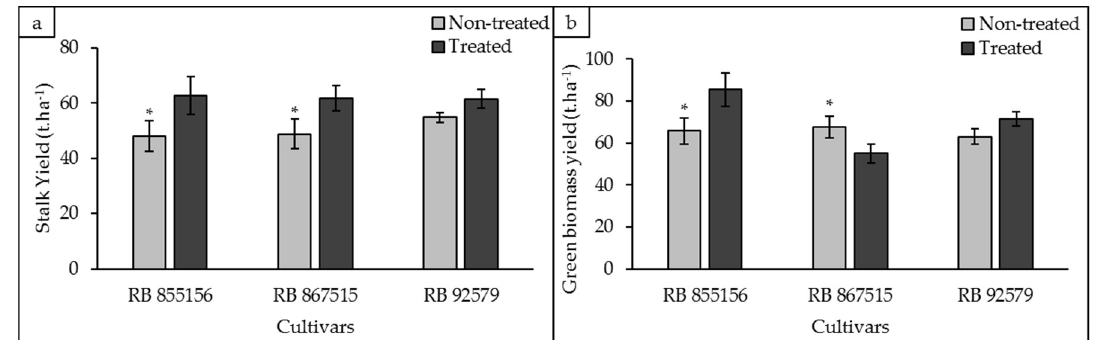
Figure 8. ( a ) Tons of cane per hectare (stalk yield) and ( b ) green biomass yield of sugarcane plants treated with pyraclostrobin and control plants. The results represent the average of three replications. * Indicates a significant difference among treatments by the Tukey test at 5% probability. The bar indicates the standard error of the mean.